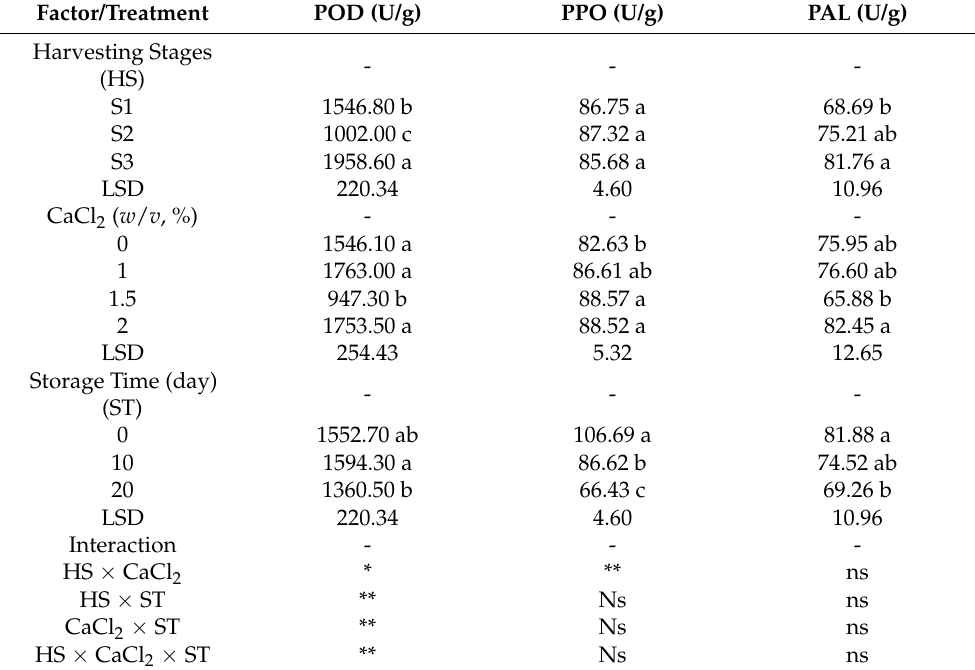
Table 3. Main and interaction effects of harvesting stages (mature green S1, breaker S2, and half ripe S3), CaCl 2 (0, 1, 1.5 and 2%, w / v ), and storage durations (0, 10, and 20 days) on plant defense